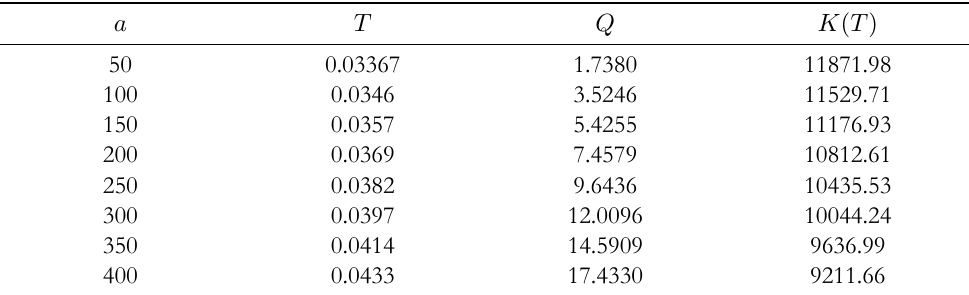
Table 2: Variation in T; Q & K ( T ) with initial demand (a)